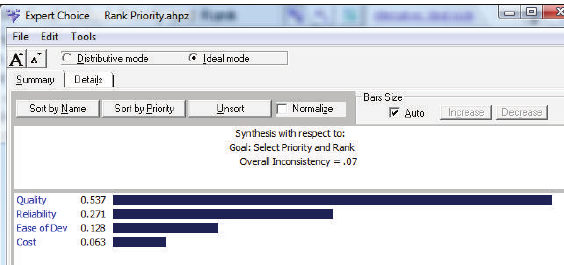
Figure 4: Expert choice output.